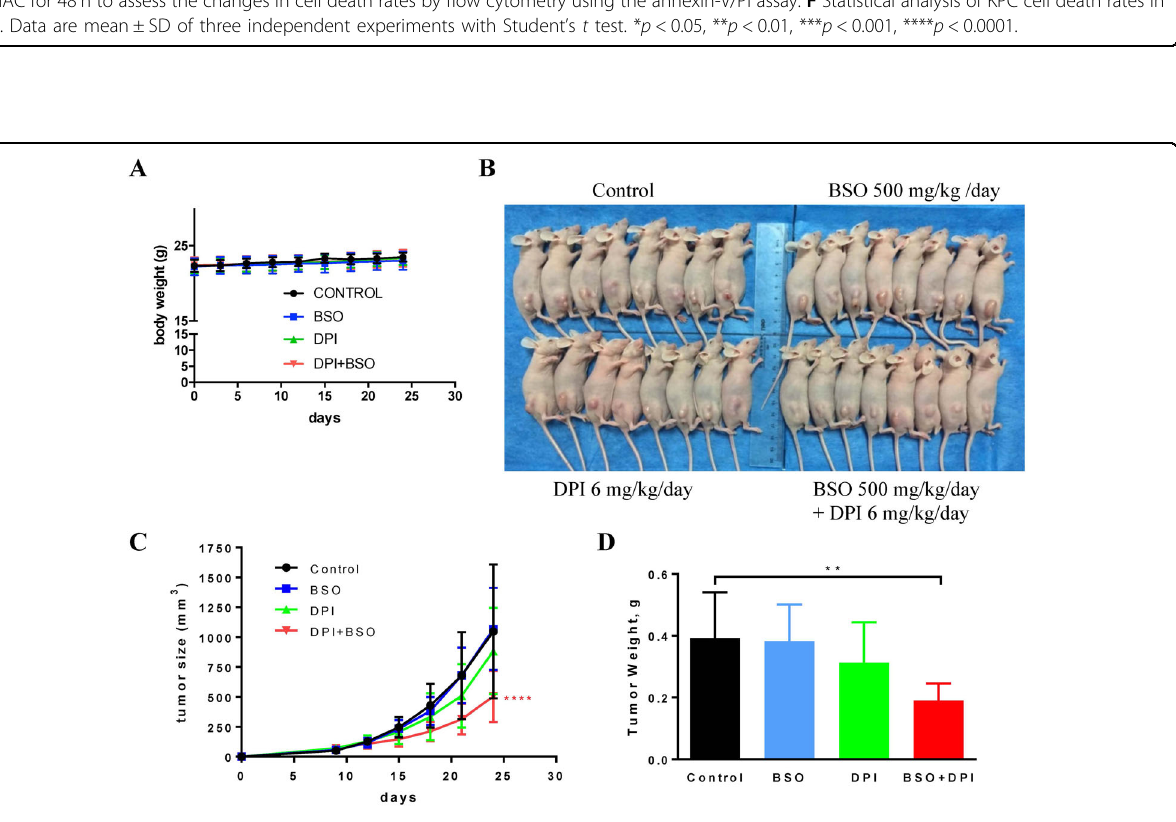
Fig. 6 Inhibition of pancreatic tumor growth in vivo by BSO and DPI combinatory treatment. A – D Athymic nude mice ( n = 32) were injected subcutaneously with 5 × 10 5 KPC cells on the right fl ank at the age of 9 weeks and randomly divided into four groups ( n = 8 per group). Treatment started 9 days after KPC cell injection with PBS, 500 mg/kg BSO, 6 mg/kg DPI, or 500 mg/kg BSO plus 6 mg/kg DPI. When the tumor diameter reached 18 mm in a few mice, all mice were sacri fi ced as mandated by the animal care protocol, and tumor nodules were excised for subsequent statistic comparison in size and weight. A Body weight changes in all 32 mice starting from KPC cell injection. No difference was noted in all four treatment groups. Two-way ANOVA was used for statistical analysis. B Photographic gross comparison of athymic nude mice bearing KPC cell xenografts on the right fl ank. C Tumor volumes were measured throughout the experiment to evaluate the effect of drug treatment using the following equation: tumor volume (mm 3 ) = L × W × ( L + W )/2 × 0.526. Data presented are mean tumor volume in mm 3 ± SD. Two-way ANOVA was used for statistical analysis. **** p < 0.0001. D Statistic analysis of tumor weight among four treatment groups. Data presented are mean tumor weight ± SD (gram). Student ’ s t test. ** p < 0.01.